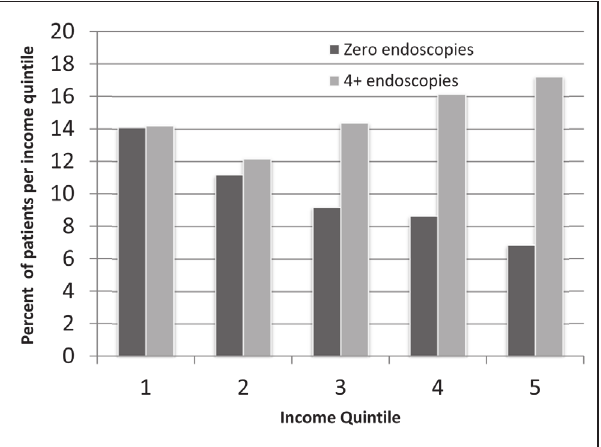
Figure 7) Comparison of percentage of patients undergoing zero versus four or more endoscopies, stratified according to income